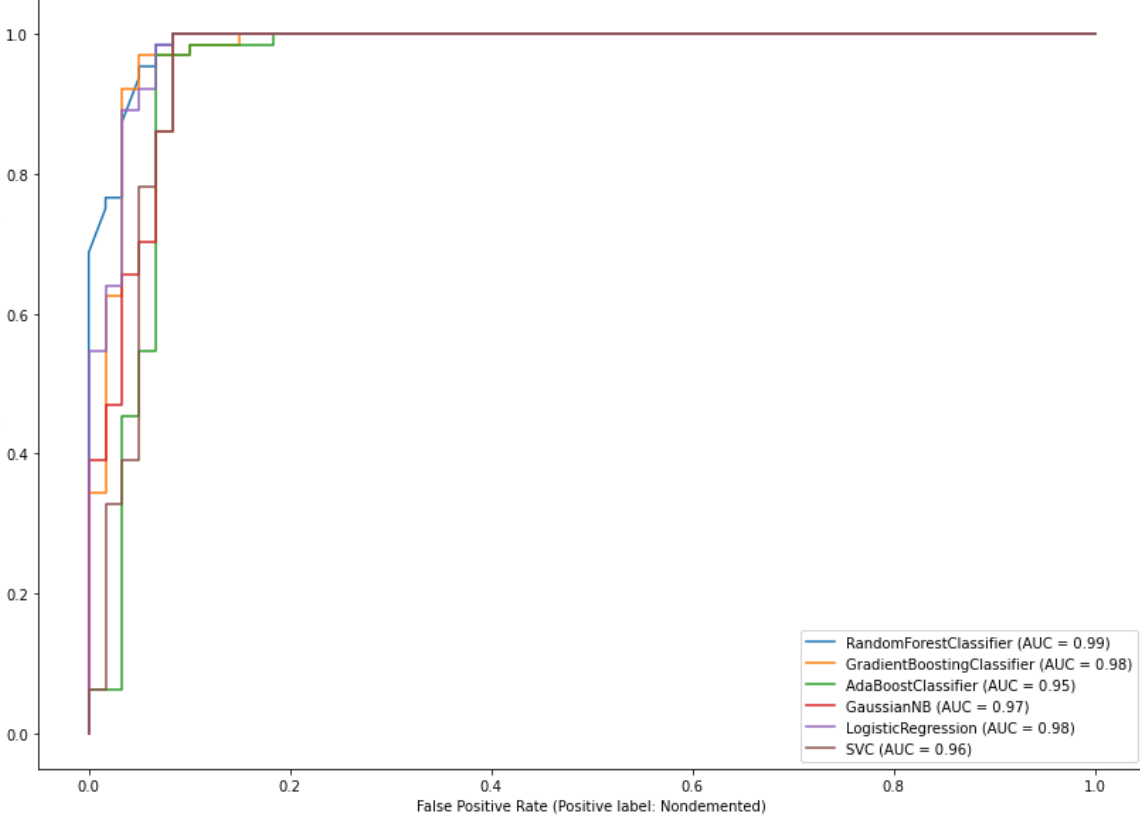
Figure 7. The area under the curve (AUC) of the classification performance of each algorithm.